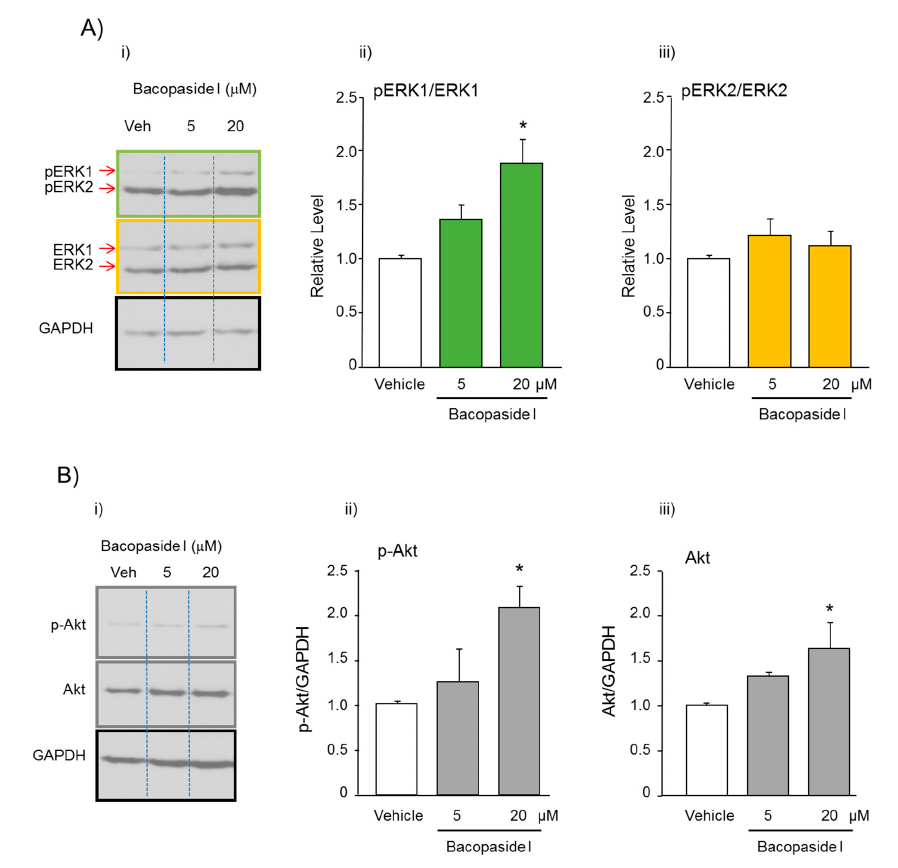
Figure 6. Effect of bacopaside I on the expression levels of proteins related to proliferation in cultured neural progenitor cells (NPCs) derived from the dentate gyrus. NPCs were incubated with vehicle or bacopaside I (5 and 20 μ M) for 24 h. ( A ) i: Typical photos indicating the expression levels of p-Erk1, p-Erk2, Erk, Erk2, and GAPDH. ii and iii: Quantitative comparisons of changes in the expression ratios between phosphorylated and non-phosphorylated proteins. ( B ) i: Typical photos indicating the expression levels of p-Akt, Akt, and GAPDH. ii and iii: Quantitative comparisons of the levels of each protein in the NPCs. The expression levels of GAPDH were used to normalize the signals between various samples. Each data column represents the mean ± S.E.M. ( n = 4). * p < 0.05. versus vehicle group.